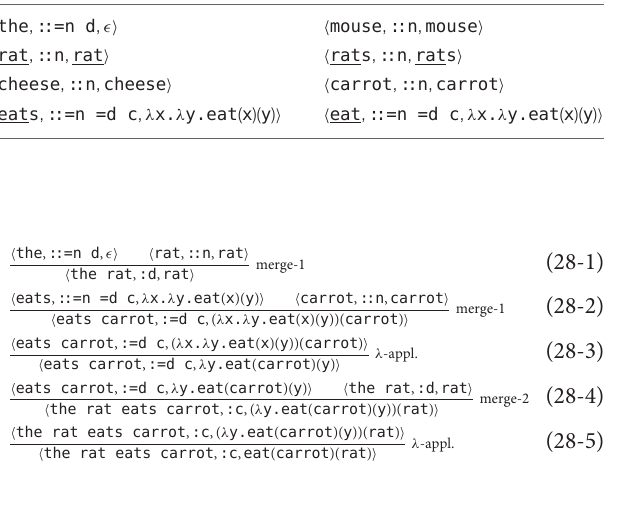
TABLE 10 | Learned minimalist lexicon X 4 at time t = 4. TABLE 11 | Revised minimalist lexicon X 41